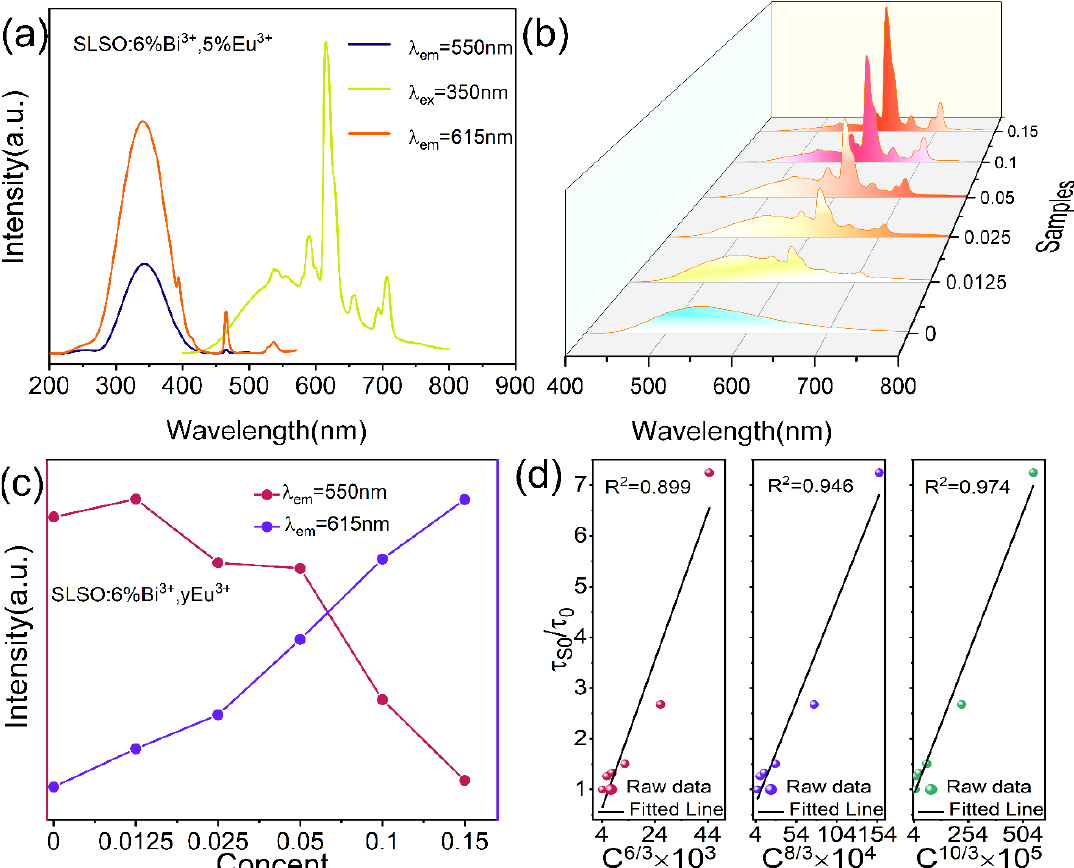
Figure 2. ( a ) Excitation and emission spectra of SLSO:0.06Bi 3+ , 0.05Eu 3+ ; ( b ) emission spectra of SLSO:0.06Bi 3+ , y Eu 3+ ( λ ex = 350 nm); ( c ) Emission intensities of SLSO:0.06Bi 3+ , y Eu 3+ ( λ em = 550 and 615 nm); ( d ) relationship between τ S0 / τ 0 with C 6/3 , C 8/3 , and C 10/3